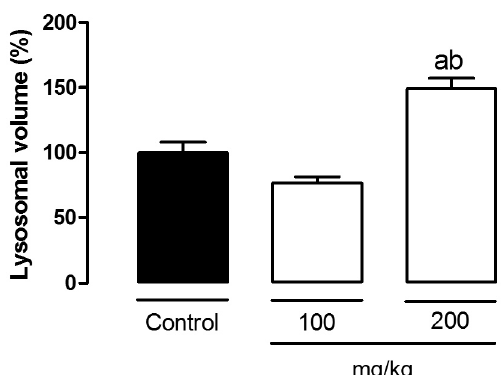
FIGURE 4 - Lysosomal volume of resident macrophages from mice fed regular chow (Control Group), treated with 100 mg/kg b.w. of CLD (Group 100), and 200 mg/kg b.w. (Group 200). a p<0.001 compared to Control. b p<0.001 compared to 100. Results are presented as % relative to control.